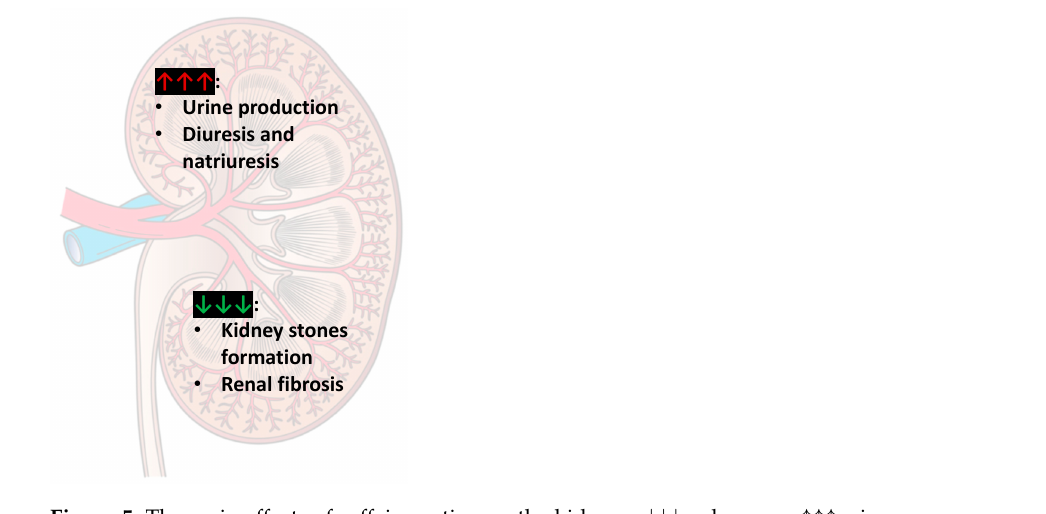
Figure 5. The main effects of caffeine action on the kidneys. ↓↓↓ —decrease, ↑↑↑ —increase